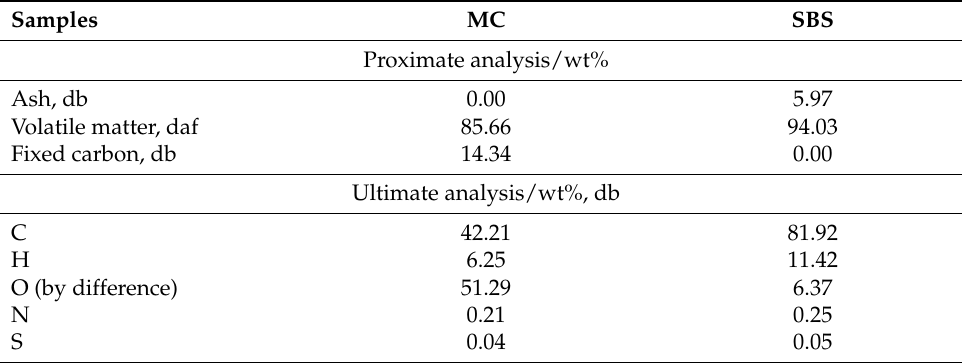
Table 1. Proximate and ultimate analyses of MC and